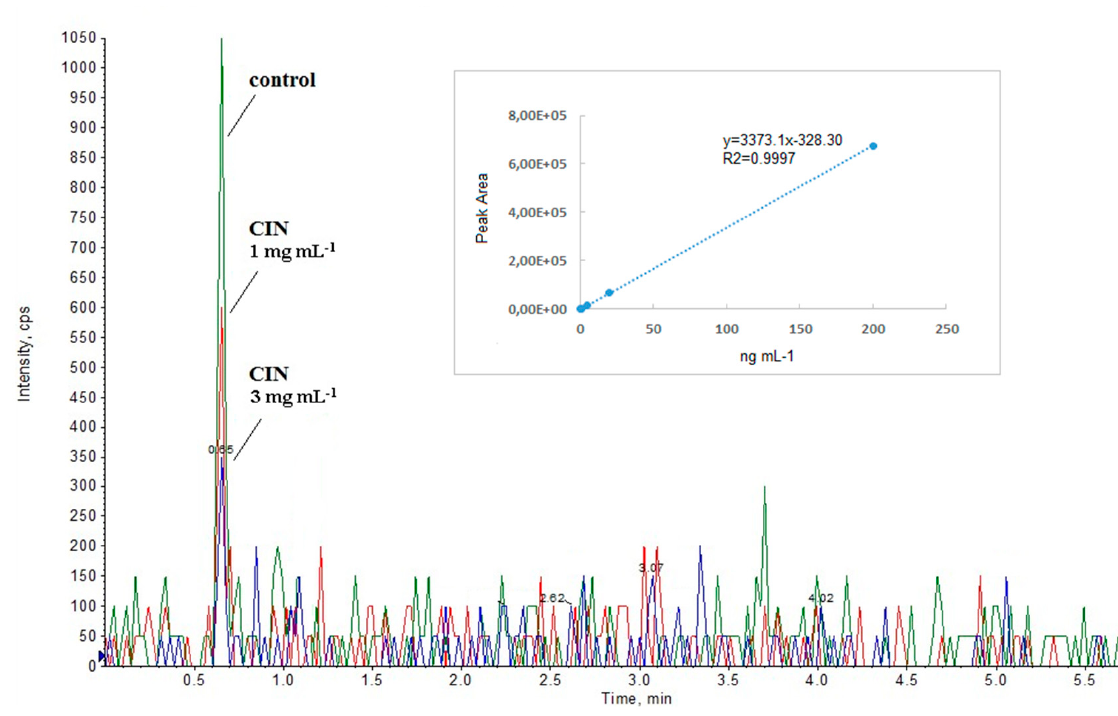
Figure 2. Representative LC- MRM chromatograms for m / z 172 > 102 transition attributed to C4-HSL in the control culture grown in standard conditions (control) and with 1 and 3 mg mL − 1 trans -cinnamaldehyde (CIN). The inset shows the calibration curve built by plotting peak area vs standard C4-HSL concentration.